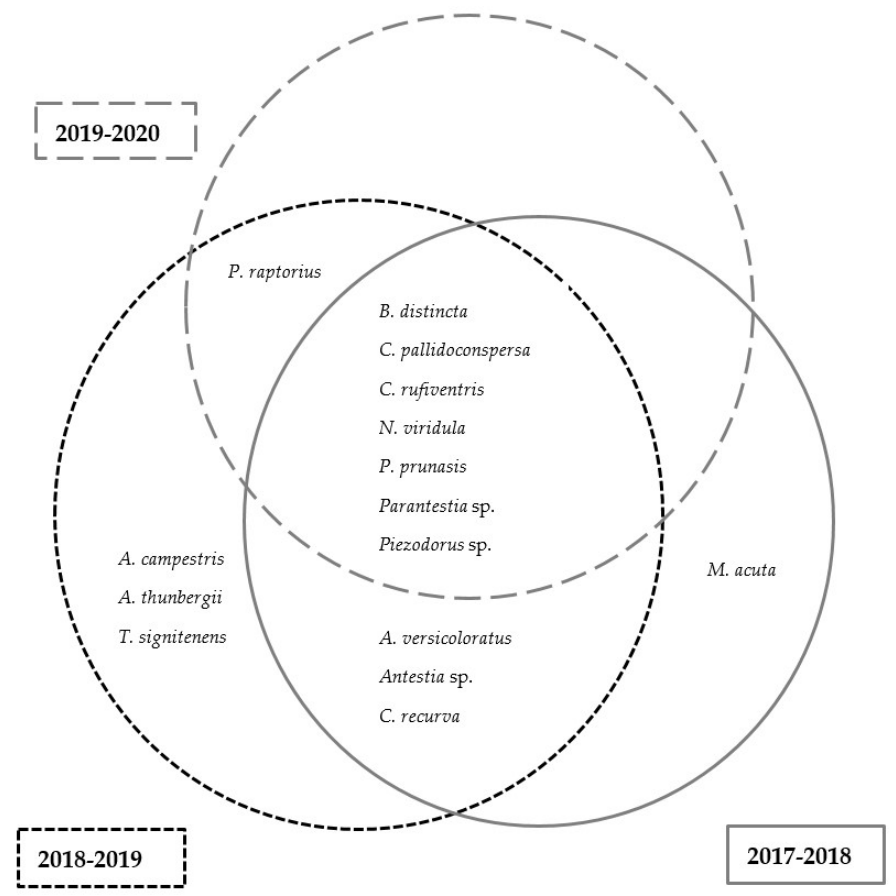
Figure 5. Stink bug species presence across three growing seasons (2017–2020) in the Limpopo growing region.